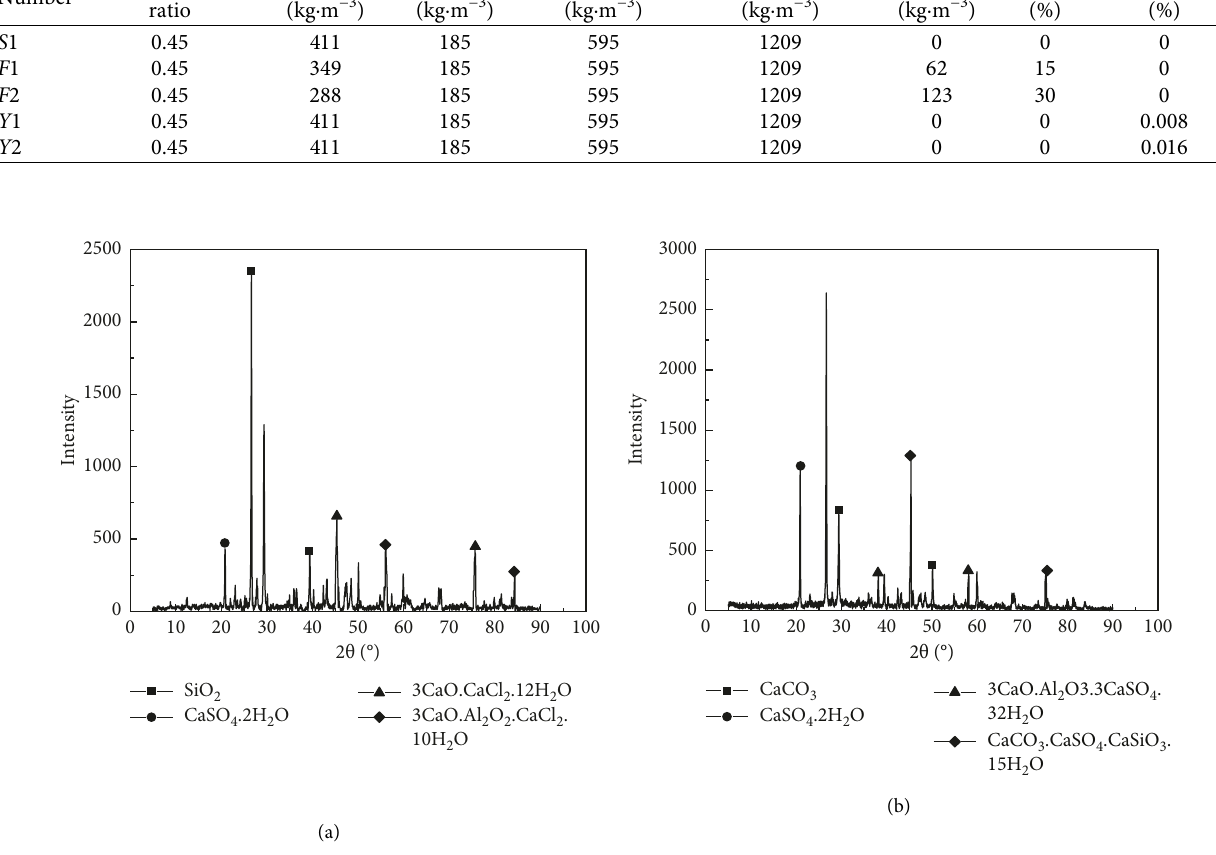
Figure 1: XRD diffraction patterns of the spalling residue of